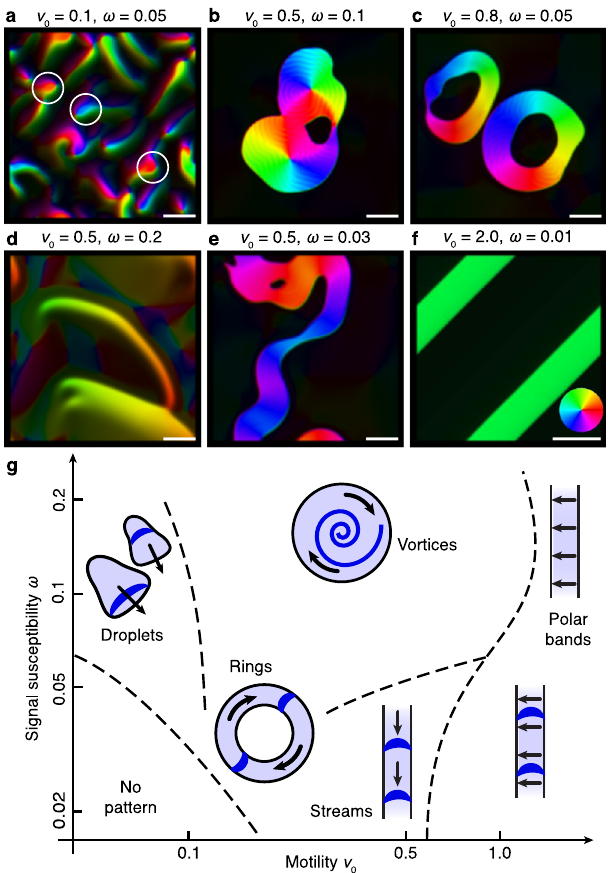
Fig. 2 | Principal collective dynamic states in the hydrodynamic model. The phase diagram of dominant (meta-stable) dynamic states in the ω (cid:3) v 0 (signal susceptibility and motility) parameter space is shown in the lower panel g , and snapshots of corresponding numerical simulations of the hydrodynamic model, startingfromahomogeneousinitialdensity ρ 0 =0.6andrandominitialexcitations of the signaling system are depicted in the upper panels. Colors indicate the polar orientationwithintheaggregates. a Activedroplets(threearehighlightedbywhite circles), b vortex states, c ring solutions, d “ silent ” polar bands, e streams, f polar bands with signaling activity. See Supplementary Movies 2 – 7. The polar relaxation rate is set to σ = 0.02, remaining parameters are given in Supplementary Note 3. White bars indicate a length of 50